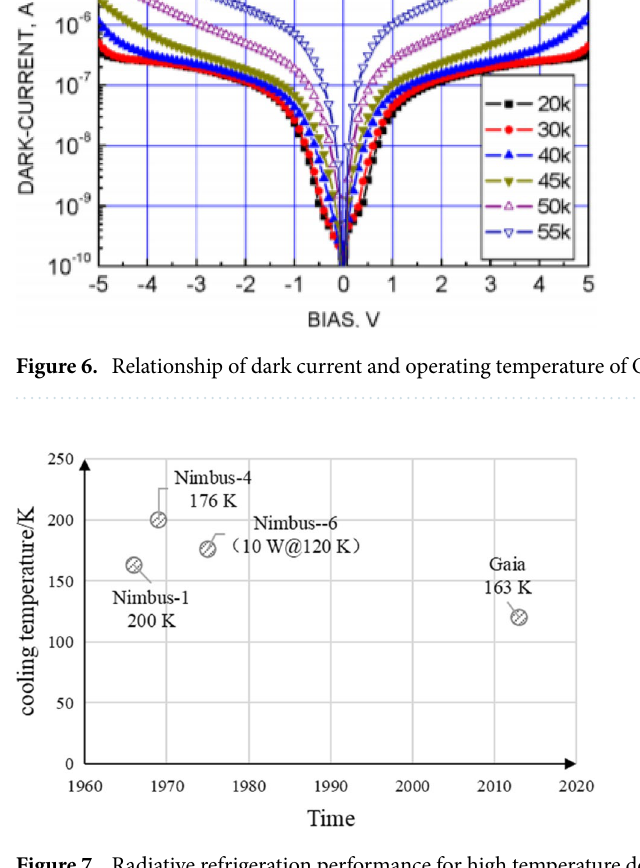
Figure 7. Radiative refrigeration performance for high temperature detection